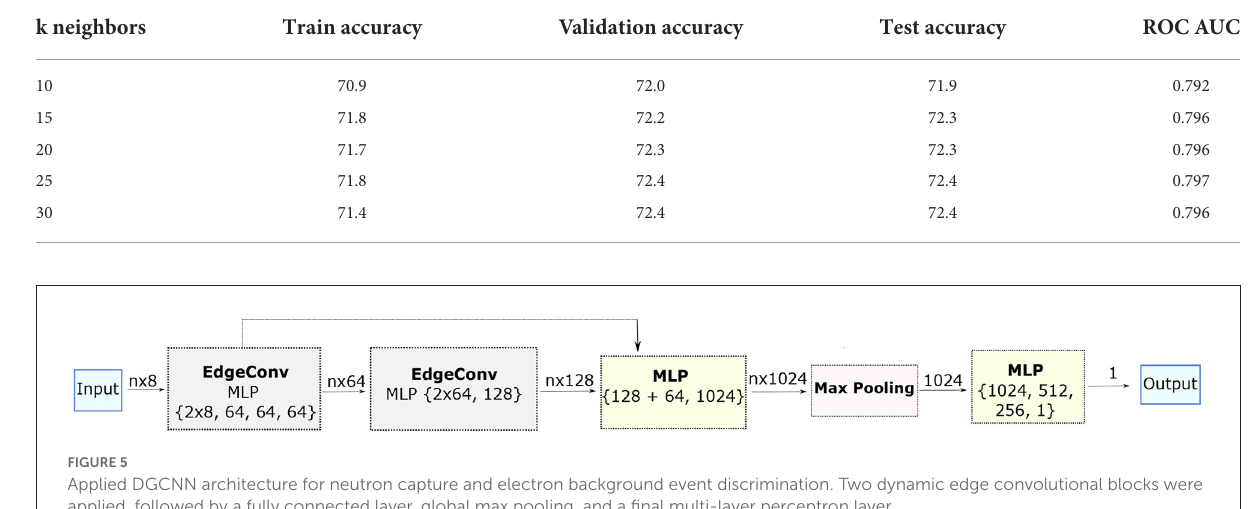
TABLE 2 DGCNN model classification accuracies for variations of the number of nearest neighbors k in the DGCNN dynamic edge convolution blocks from 10 to 30 in increments of 5. k neighbors Train accuracy